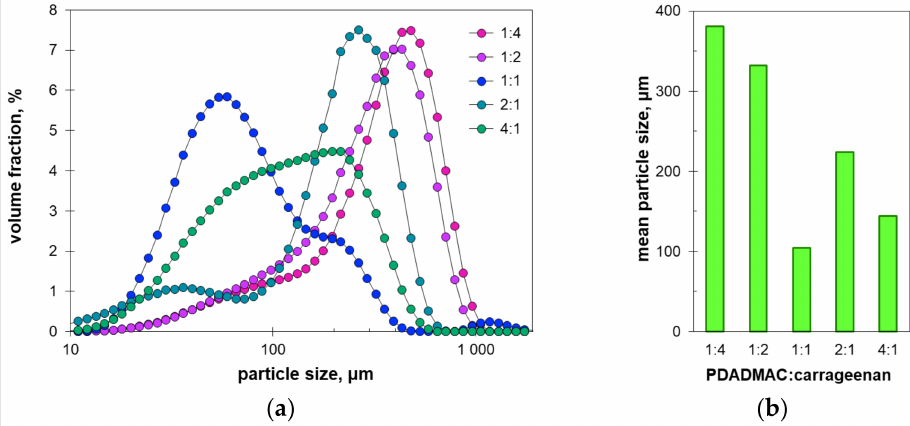
Figure 6. ( a ) Particle size distributions and ( b ) average particle size of the suspensions with the indicated polyelectrolyte